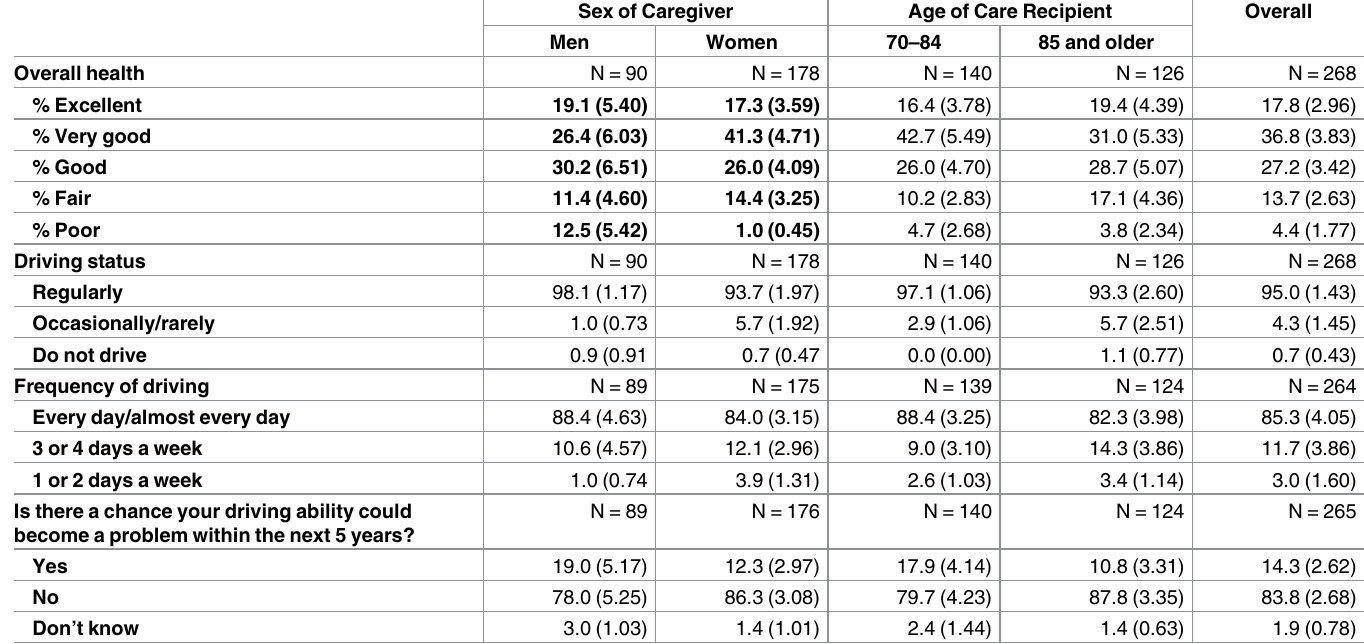
Table 3. Transportation caregiverhealth and driving by sex, age of care recipient, and overall (standard error of the